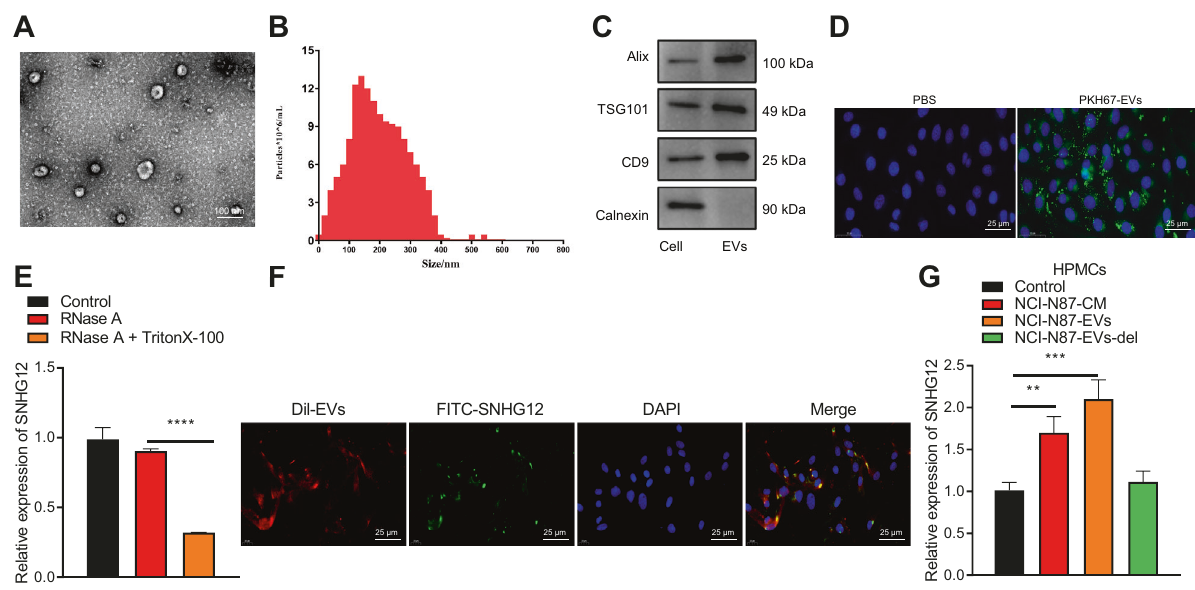
Fig. 3 EVs deliver SNHG12 to HPMCs. A The morphology of EVs observed using TEM (scale bar = 100 nm). B EV diameter distribution measured using NTA. C The expression patterns of protein markers of EVs (Alix, TSG101, CD9, and Calnexin) detected by western blot analysis. D The admission of NCI-N87-EVs labeled with fl uorescent PKH67 into HPMCs (PKH67 labeled EVs were green, DAPI stained nuclei blue, scale bar = 25 μ m) observed by confocal laser scanning microscope through z -sections and orthogonal views analysis. E The expression pattern of SNHG12 after EVs were treated with RNase and Triton X100 detected using RT-qPCR. F The enter of FITC-labeled SNHG12 (green) into HPMCs via Dil-labeled EVs (red) observed by confocal laser scanning microscope through z -sections and orthogonal views analysis (DAPI: blue, scale bar = 25 µm). G The SNHG12 expression pattern in HPMCs detected by RT-qPCR after co-culture of HPMCs and NCI-N87-EVs. p < 0.05, ** p < 0.01, *** p < 0.001, **** p < 0.0001. The experiment was conducted three times